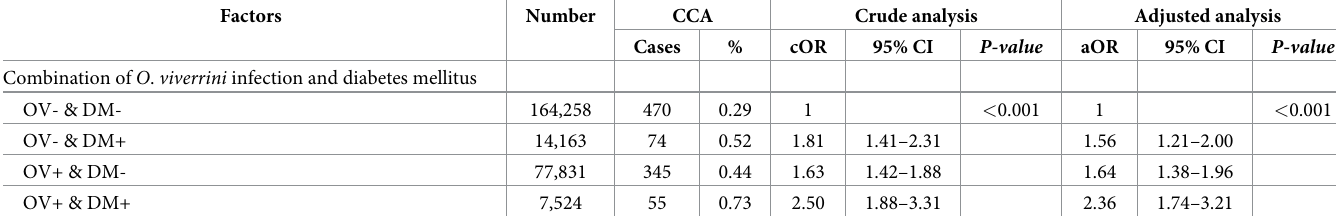
Table 3. Association of combinations of O . viverrini infection and diabetes mellitus with cholangiocarcinoma using multilevel mixed-effects logistic regression. The data are presented as numbers of participants, numbers and percentages having cholangiocarcinoma, crude odds ratios and their 95% confidence interval and p-value from likelihood-ratio chi-square tests, and adjusted odds ratios and their 95% confidence interval and p-values from likelihood-ratio chi-square tests for various combina- tions of O . viverrini infection and diabetes mellitus. Factors Number CCA